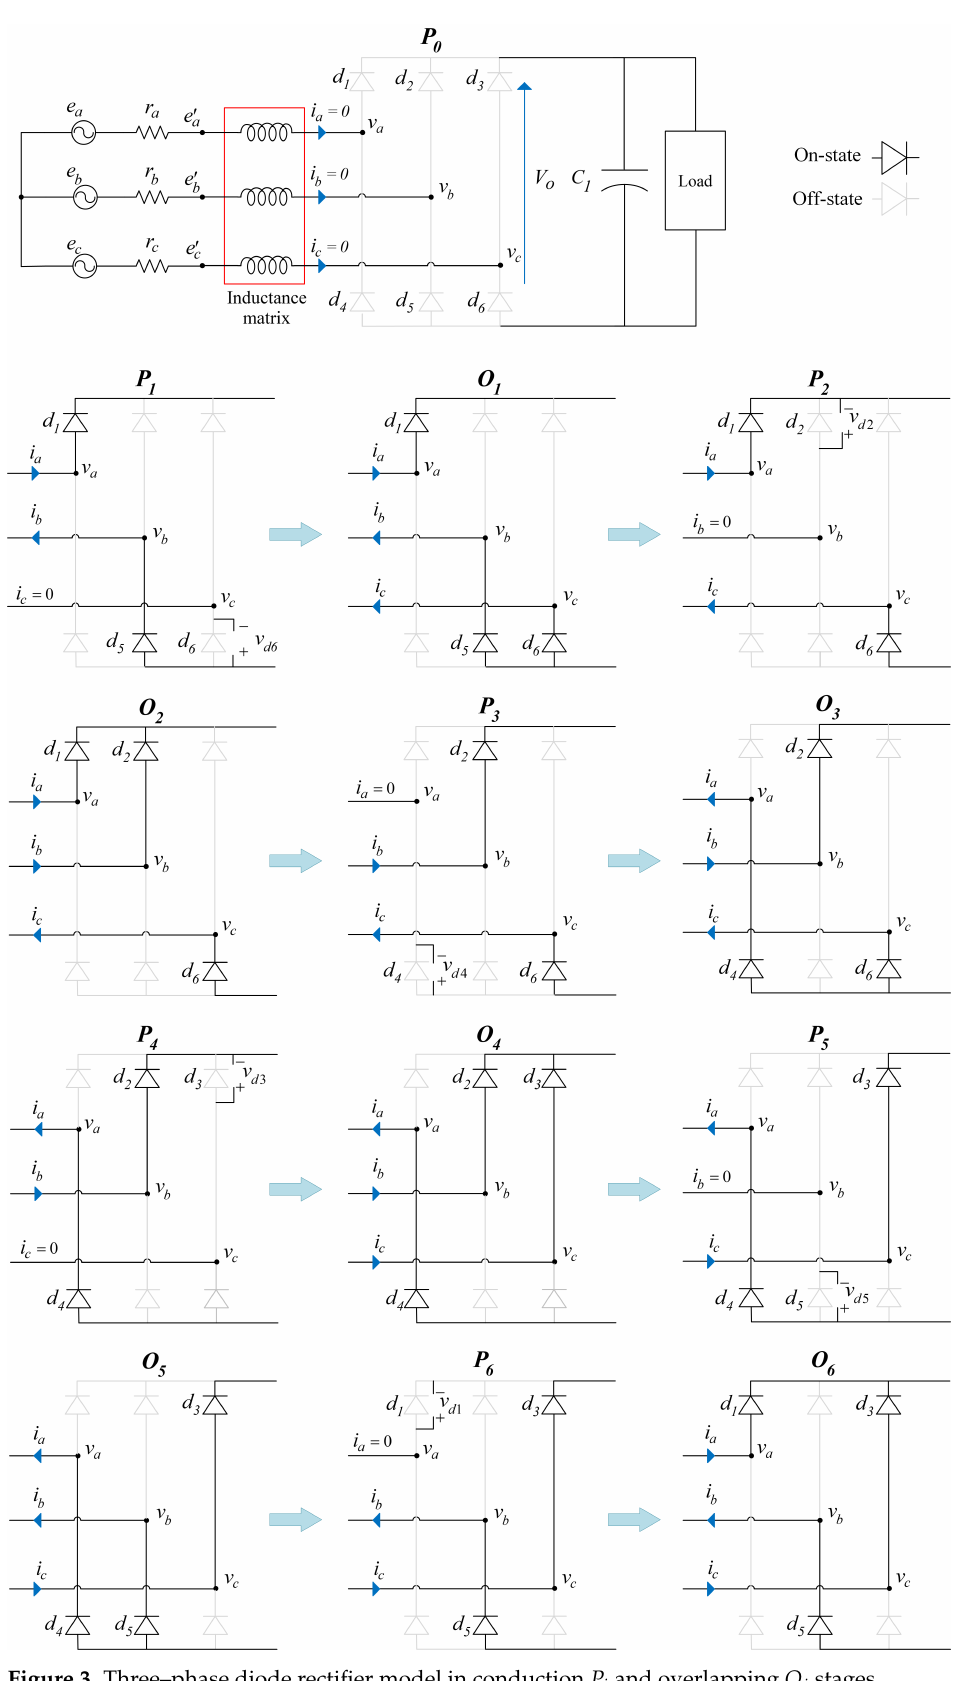
Figure 3. Three–phase diode rectifier model in conduction P i and overlapping O j